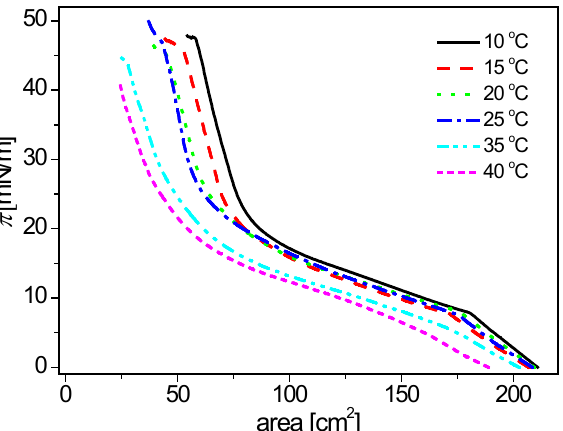
Figure 3. Surface pressure isotherms ( π (A) ) for the synthetic sebum mixture recorded in the temperature range 10–40 °C.